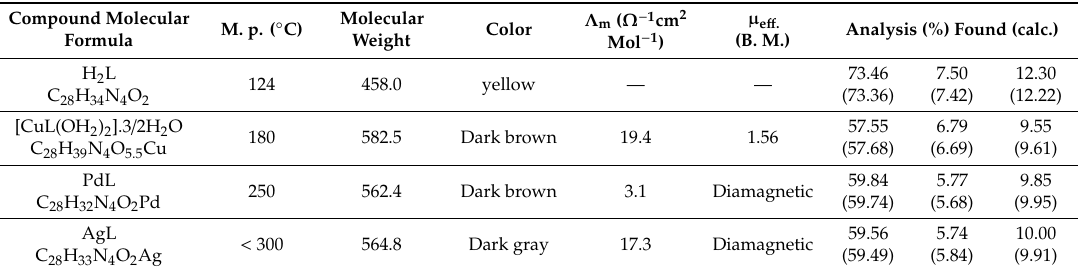
Table 2. Physicochemical and analytical data of the new titled compounds. Compound Molecular